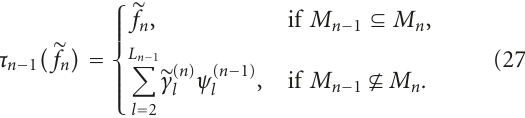
Algorithm 3 . For any n ∈ Z ≥ 0 , consider the index set J